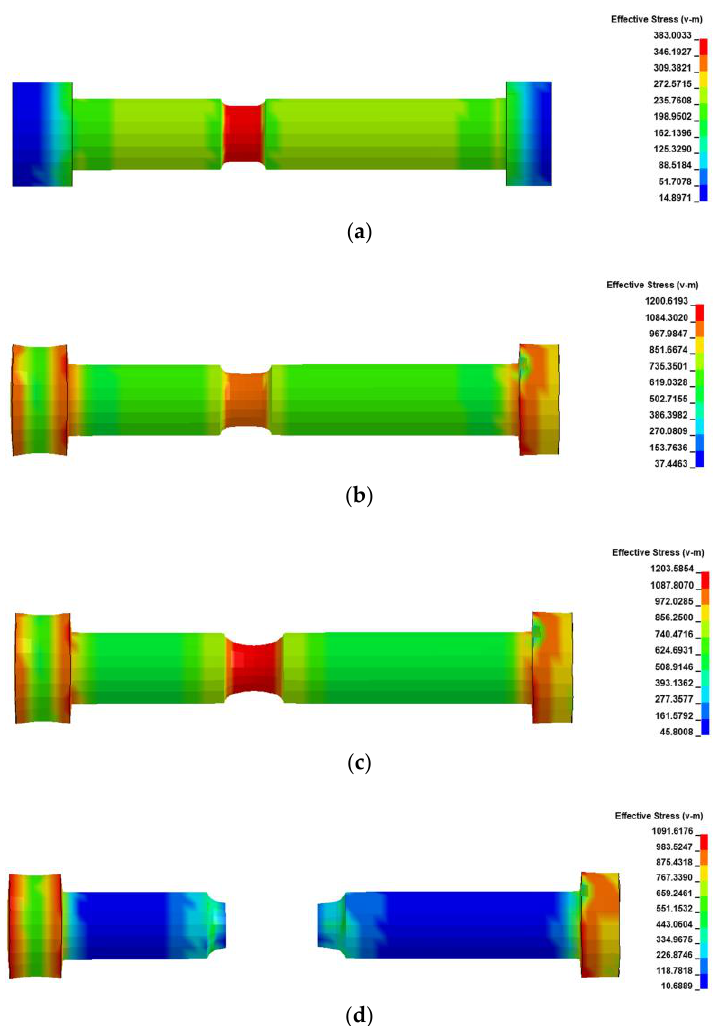
Figure 26. Effective stress contours plots of the VCSB in FEM-180: ( a ) A 2′ , ( b ) B 2′ , ( c ) C 2′ , ( d ) bolt fracture.